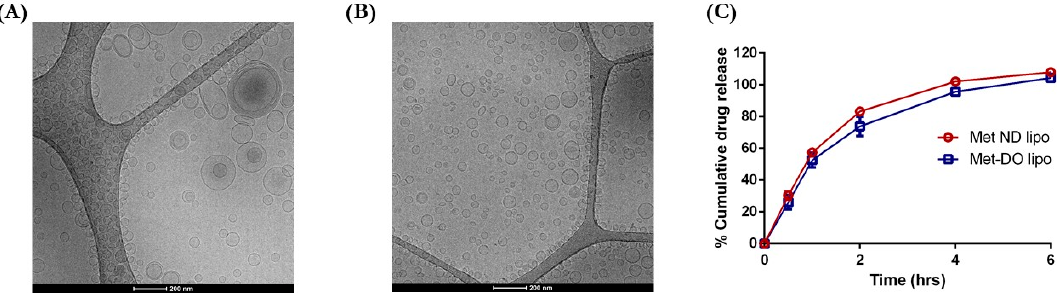
Figure 1. Preliminary characterization of liposomal formulations during development and optimization. ( A ) Cryo TEM micrographs of metformin hydrochloride (Met) ND lipo. Scale bar = 200 nm. ( B ) Cryo TEM images of Met DO lipo. Scale bar = 200 nm. ( C ) In vitro drug release profile of optimized formulation, Met ND lipo, and Met DO lipo as revealing all the drug being released with 6 h. Data represent mean ± SD ( n = 3).